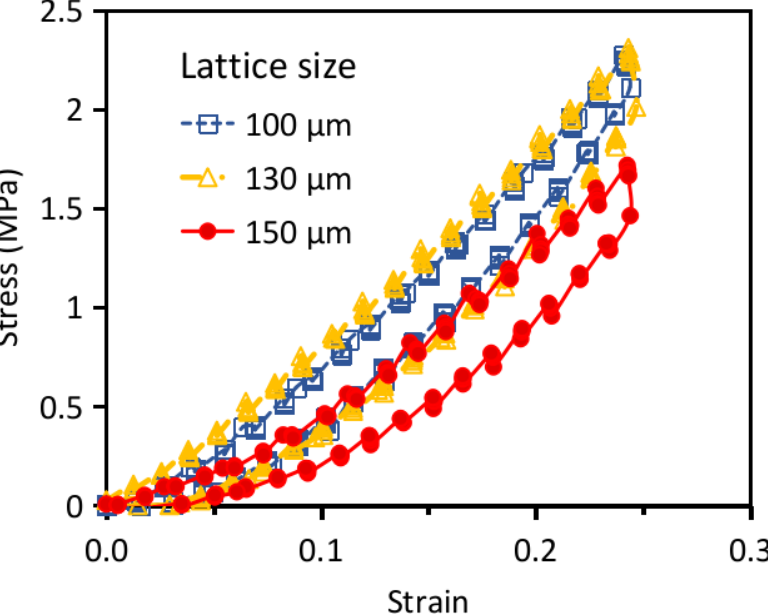
Figure 8. Comparison of the loading-unloading traces of the micro-lattice structures with different unit cell lengths.